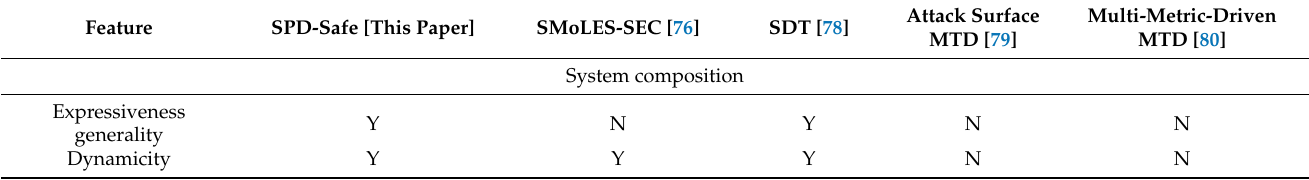
Table 1. AI (artificial intelligence) modeling